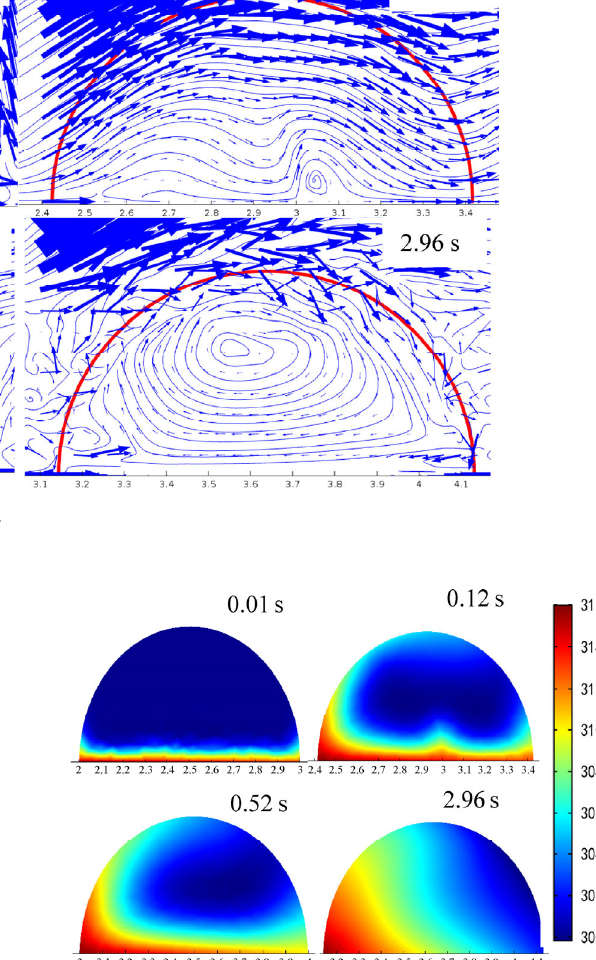
Fig. 7 Temperature distribution in silicone-oil process at θ = 90° and G = 20 K/mm.